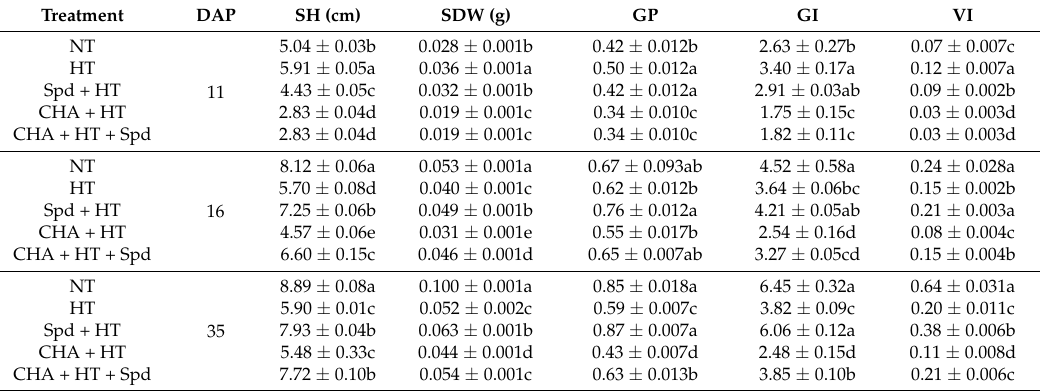
Table 1. Effects of exogenous Spd and CHA on seed germination and seedling growth during rice seed maturity after high-temperature stress (40 ◦ C, 5 days).